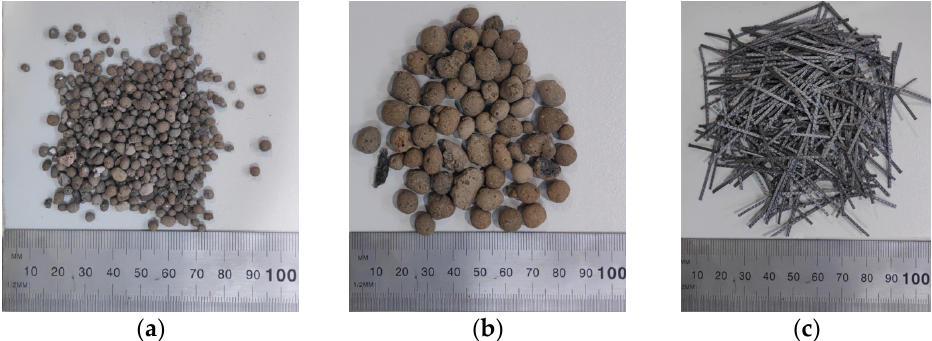
Figure 1. Types of aggregates: ( a ) expanded clay-fine; ( b ) expanded clay-coarse; ( c ) polyolefin fibers.